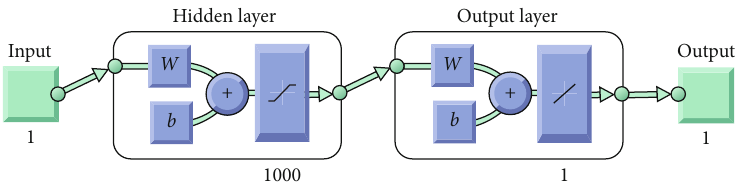
Figure 13: DNN model for fuel cell MPPT